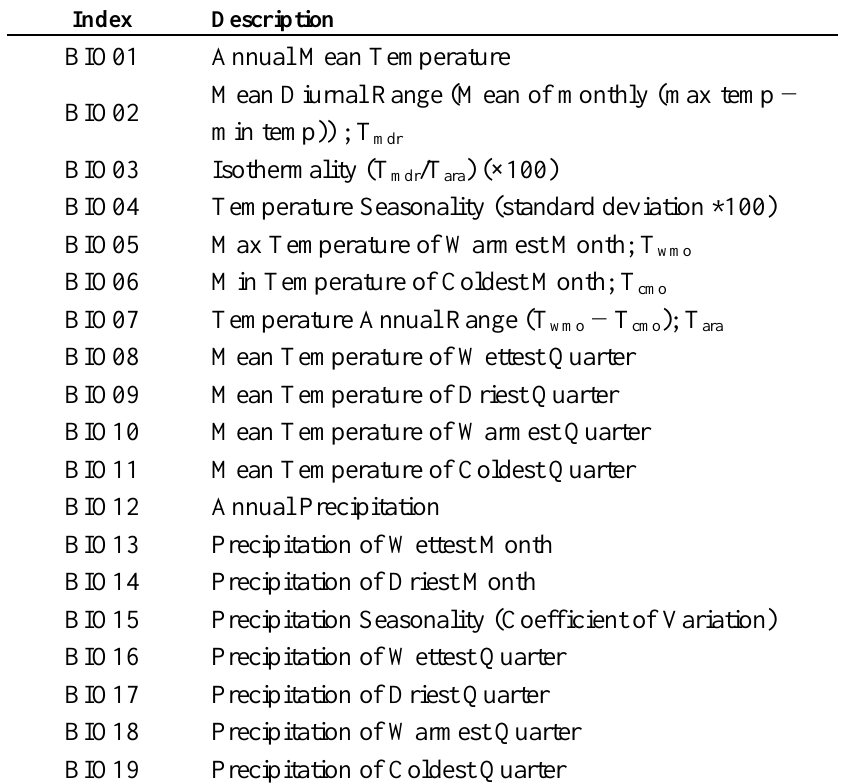
Table 2. Nineteen bioclimatic indices calculated for the analysis (after